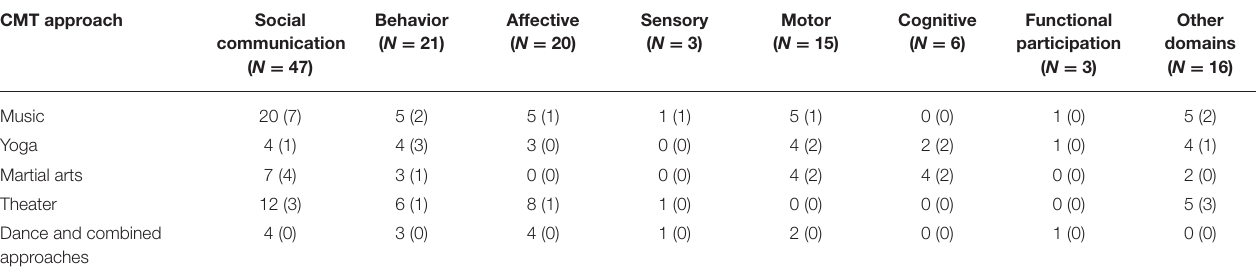
TABLE 6 | Summary of reviewed studies that assessed specific domains and number of studies that showed improvements based on ES calculations. CMT